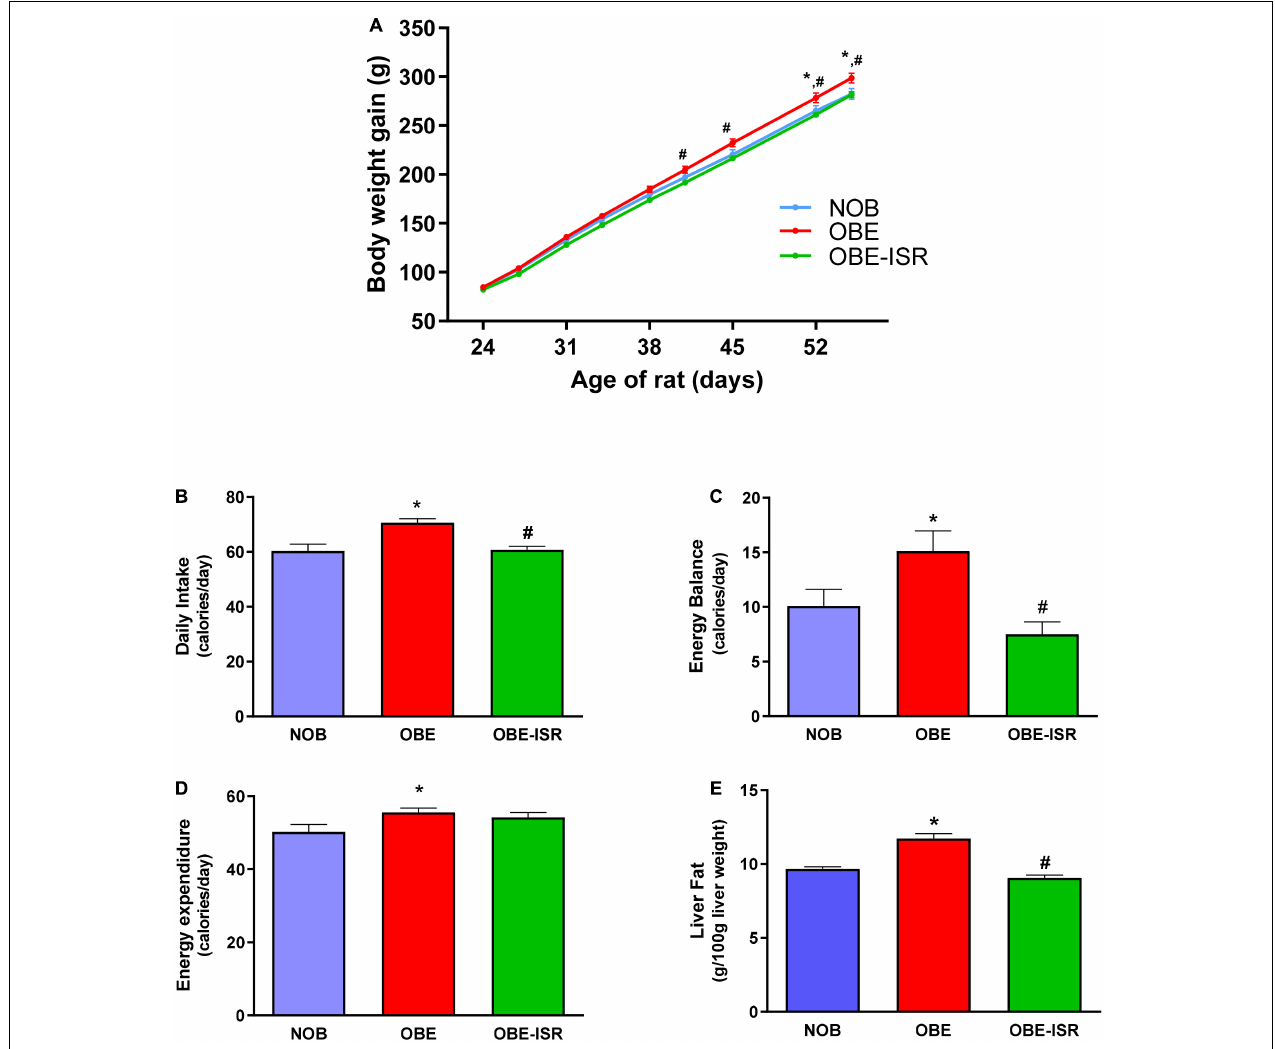
FIGURE 1 | Growth and energy expenditure in the experimental model. (A) Body Weight evolution. (B) Daily intake. (C) Energy balance. (D) Energy Expenditure. (E) Liver fat. Rats were fed a normal rodent diet (NOB), or a high-fat diet (HFD) formulated with rapidly (OBE) or with slowly digestible carbohydrates (OBE-ISR). Data expressed as mean ± SEM. *Significant difference with NOB group, p < 0.05. #Significant difference with OBE group, p <